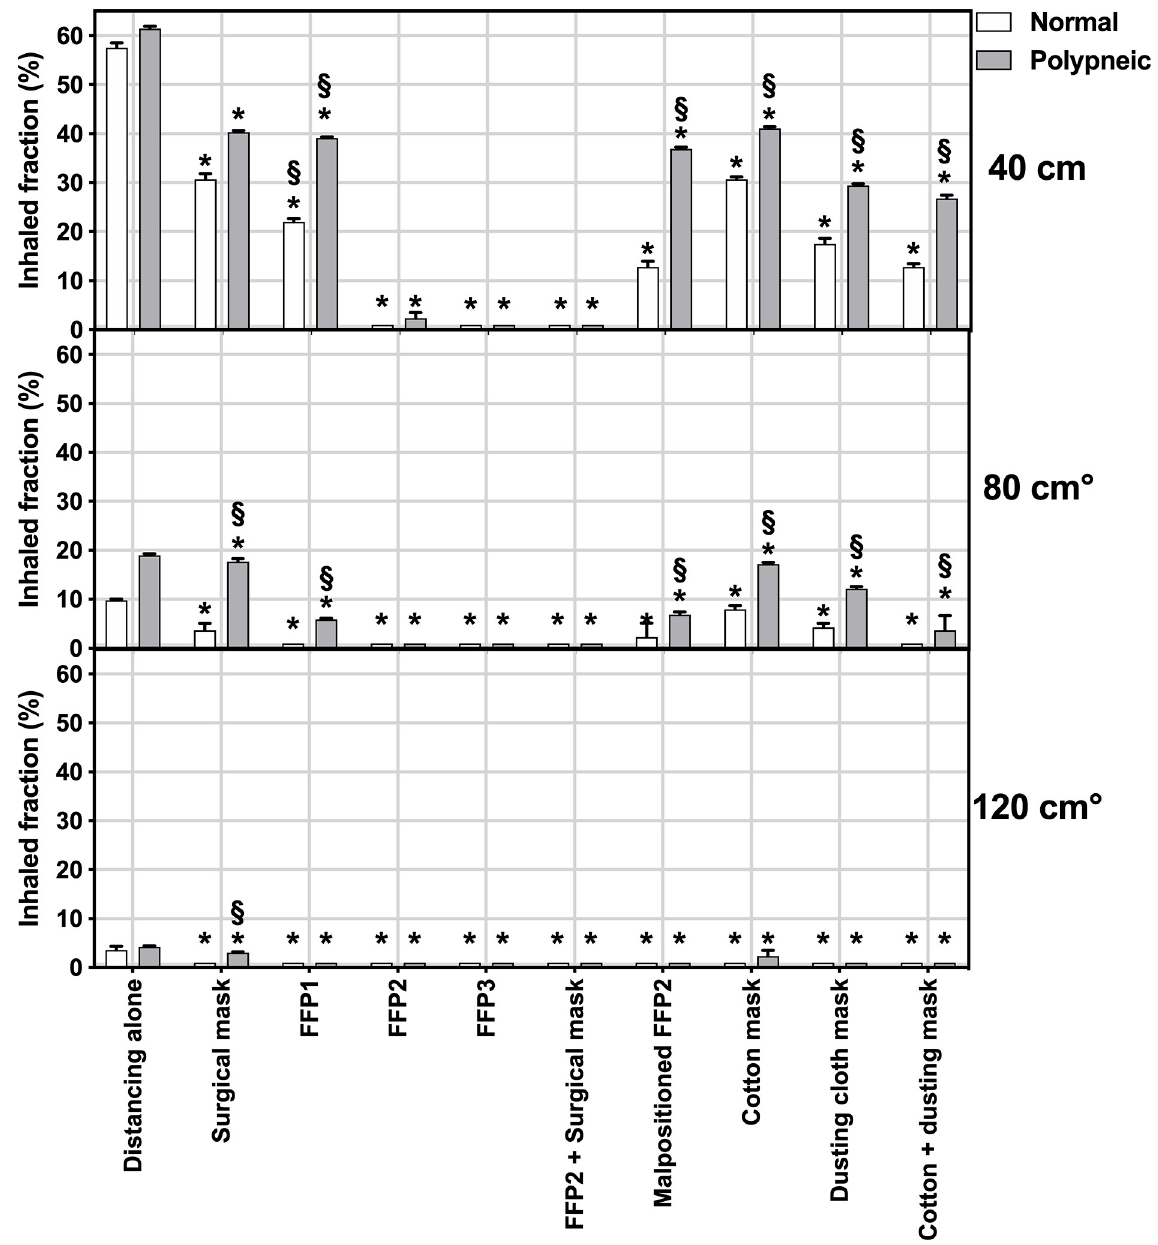
Fig 3. Effects of different distances and pattern of breathing on the inhaled fraction with the tested masks during normal (white bars) and polypneic (gray bars) pattern of breathing. The inhaled fraction is expressed as percent of the amount inhaled without mask and at zero distance from the emitter. Bars represent means, error bars the standard deviation. The horizontal gray bar represents the sensitivity limit of our technique. � Significant difference compared to distancing alone (p < 0.001), ˚Significant difference compared to distance of 40 cm, § significant difference compared to normal pattern of breathing at same distance (p <